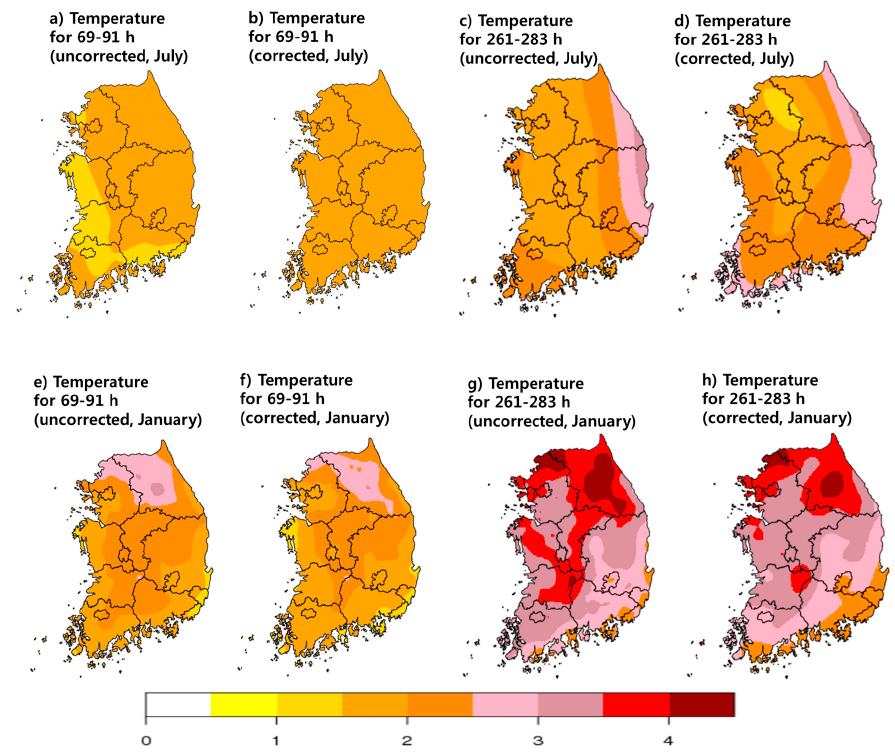
Figure 5. Spatial distributions of temperature MAEs in July 2017 and January 2018. Results are for ( a )